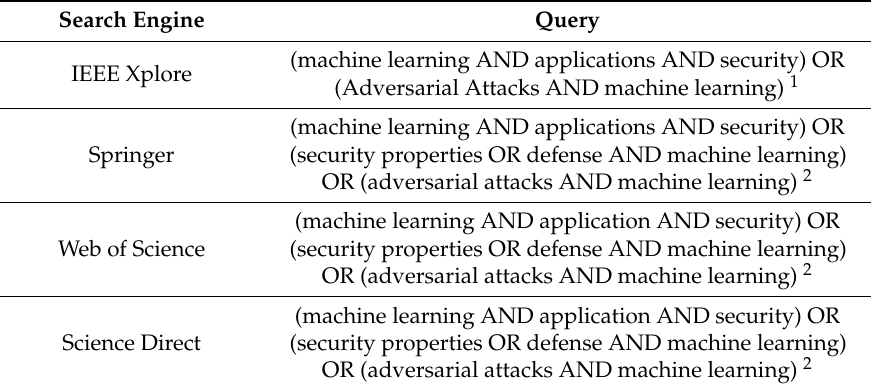
Table 1. Search queries format for search engine.